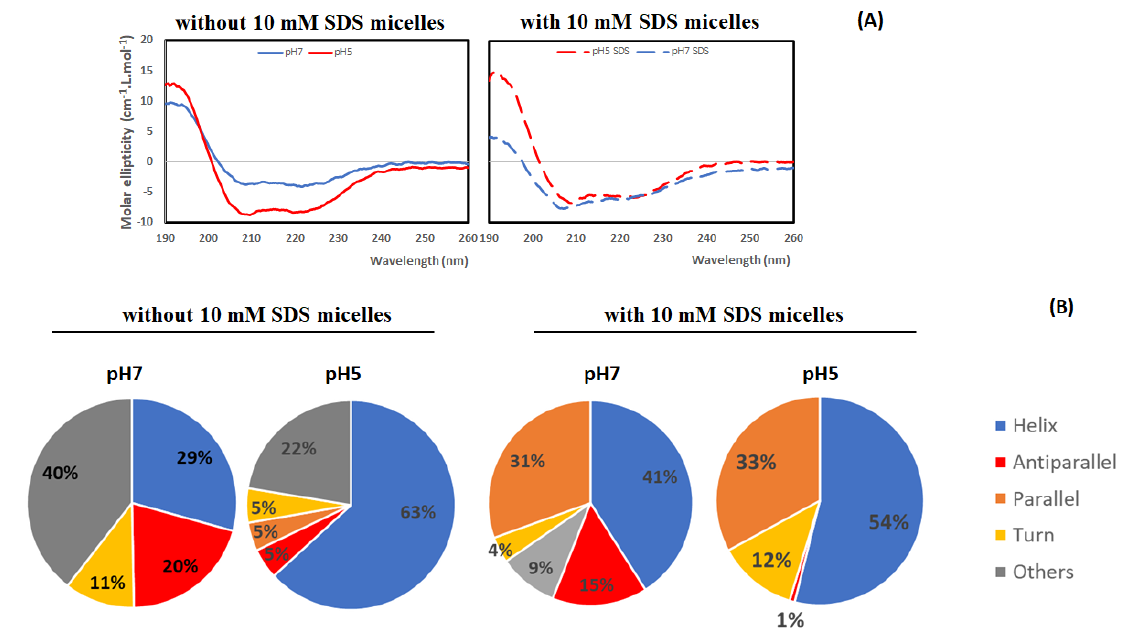
Figure 3. ( A ) Circular dichroism spectra of lacticaseicin 30 at pH 7 (blue) and pH 5 (red) recorded in the absence or presence of 10 mM SDS micelles. ( B ) The secondary structure content (%) of lacticaseicin 30 at pH 7 and 5 was predicted using the BestSel Software.